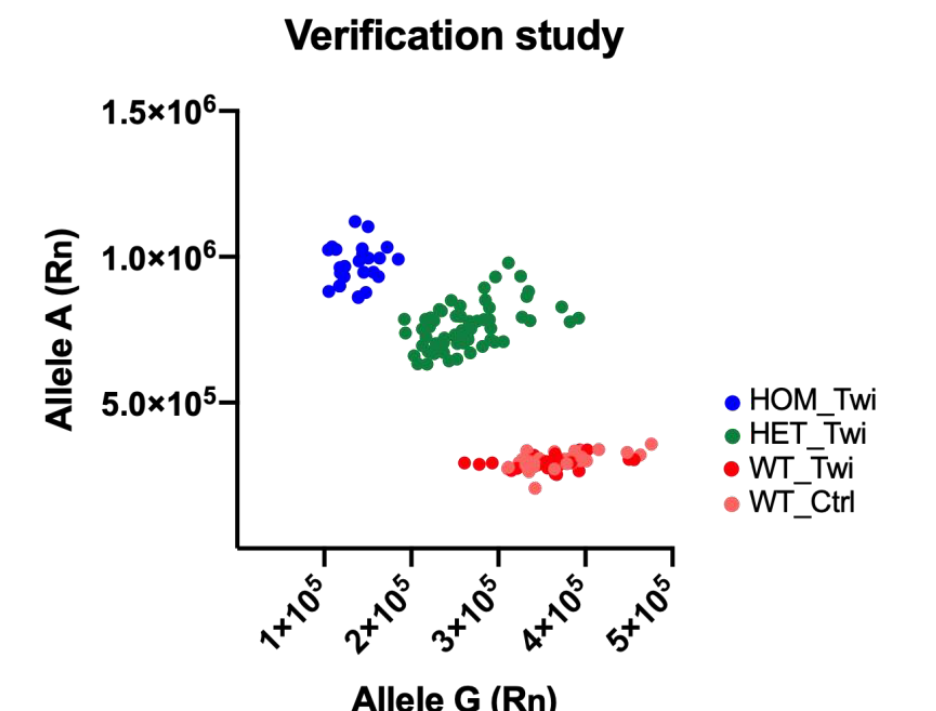
Figure 4. Genotyping of galactosylceramidase ( Galc ) SNP c.355G>A in 120 Twitcher (Twi) mice and 30 control mice (Ctrl) for the verification study, cohort A. The scatter plot of Allele G (axis x) versus Allele A (axis y) allowed us to identify the presence of the SNP in each animal. Animals homozygous for Allele G (WT) were localized in the bottom right corner of the graph (red and pink circles), animals homozygous for Allele A (HOM) were localized in the top left corner of the graph (blue circles), and animals heterozygous for Alleles A and G (HET) were localized on the diagonal (green circles). To confirm the development of the Twi phenotype in mice identified as HOM_Twi, we monitored the Twi growth between PND 22 and PND 37. As reported in Figure 5A and 5B, the HOM_Twi mice appeared essentially normal until approximately PND 28, when their growth slowed down and death occurred by ~40 days of age. As expected, the body weight (BW) of HOM_Twi mice did not show the physiological BW increase found for WT_Twi and in WT_Ctrl mice. Figure 5B visually showed the forfeit of the weight of HOM_Twi and the characteristic hunched back compared to WT_Twi mice. To evaluate the motor function, we performed the rotarod test, commonly used to evaluate motor coordination in rodents (Figure 5C). As expected, WT_Twi mice presented a rotarod performance comparable with the group of WT_Ctrl, whereas HOM_Twi performed significantly worse than all of the WT mice. Altogether these data confirm that HOM_Twi mice go on to develop the Twitcher phenotype, further corroborating the correct genotyping with the new